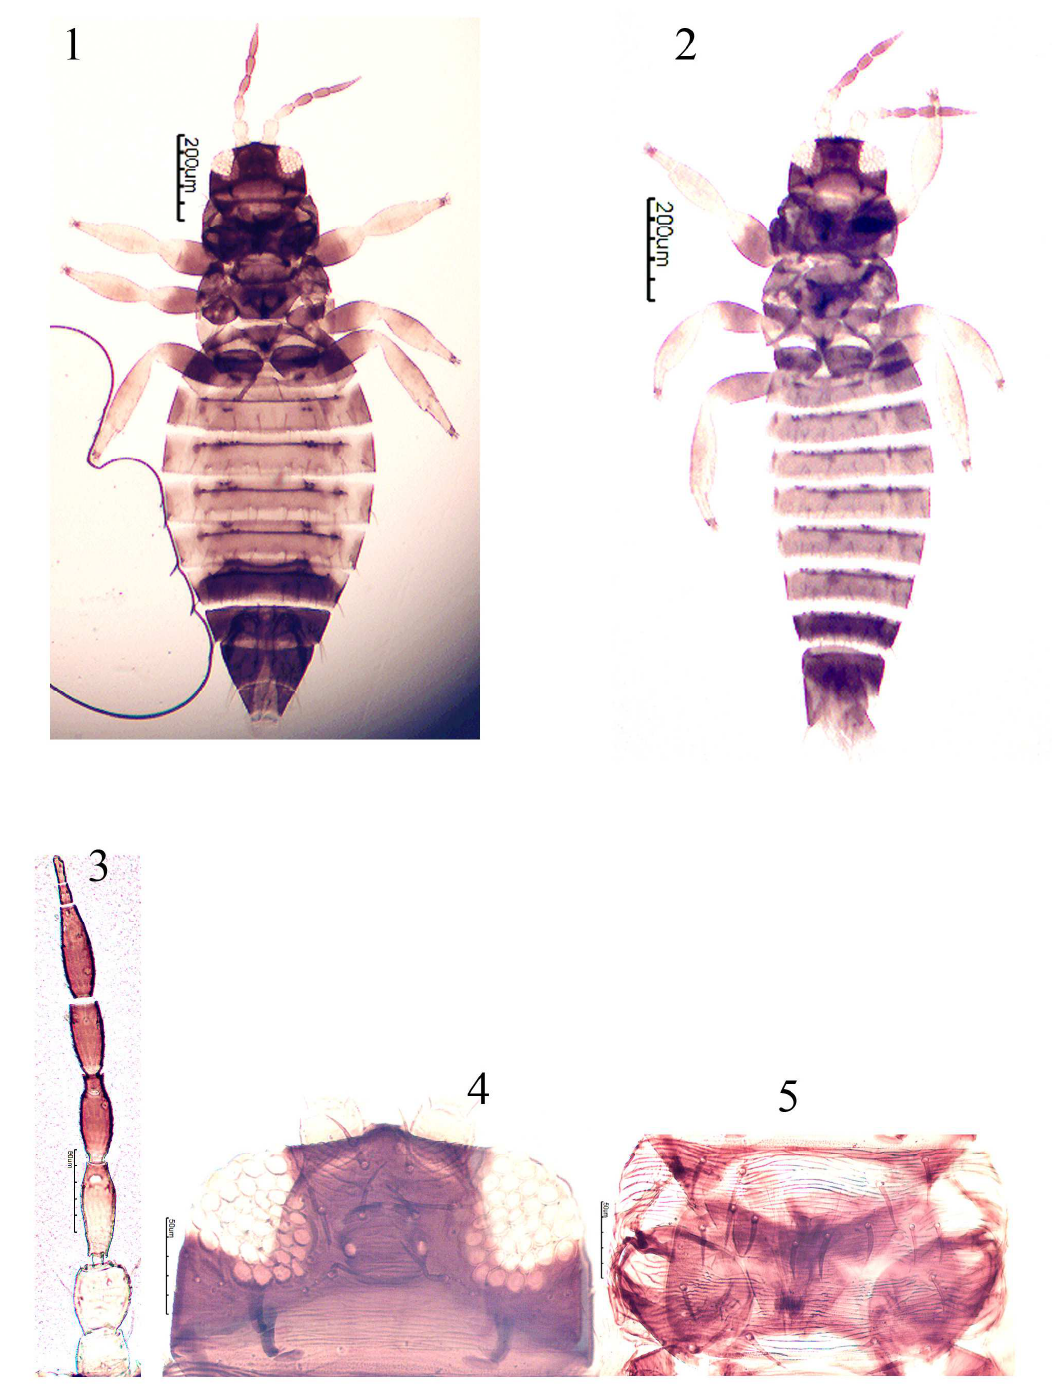
F IGURES 1–5. Sericothrips bicornis (1) female; (2) male; (3) Antenna (female); (4) Head (female); (5) Pronotum